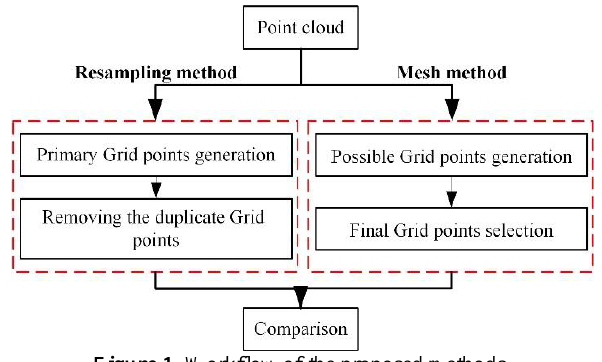
Figure 1 . Workflow of the proposed methods.